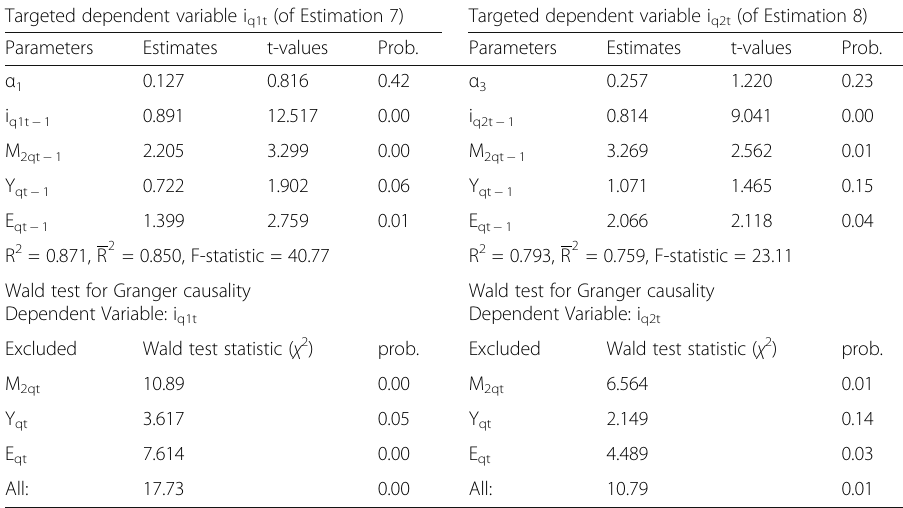
Table 6 Dynamics of interest rates involving quarterly dataset: (M2 money growth is used) Targeted dependent variable i q1t (of Estimation